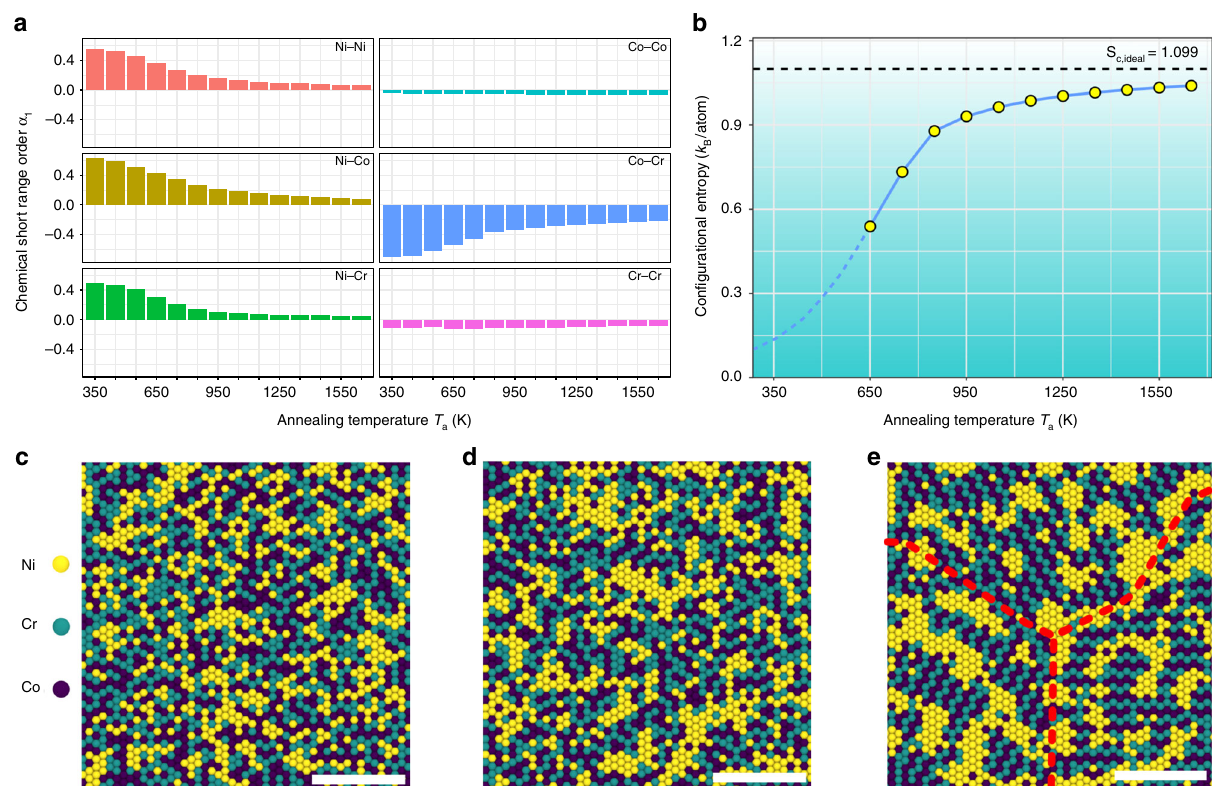
Fig. 1 Local chemical ordering (LCO) at different annealing temperatures T a . a Pairwise chemical short-range order parameter α 1 (see Methods) at different annealing temperatures. b Con fi gurational entropy of the NiCoCr ternary solution and its temperature dependence. Points are data estimated through the cluster variation method (CVM) with pair approximation, connected using a blue line as a guide for the eye. This approximation becomes increasingly inadequate at high LCO; thus, a dashed line is used instead to project the trend at low T a . Black dashed line denotes the S c , ideal . c – e Representative con fi gurations at T a = 1350, 950, and 650 K, respectively. The red dashed lines indicate the cobalt – chromium (Co – Cr) domain boundaries. The scale bar is 3 nm. All atomic con fi gurations are viewed on the (111)